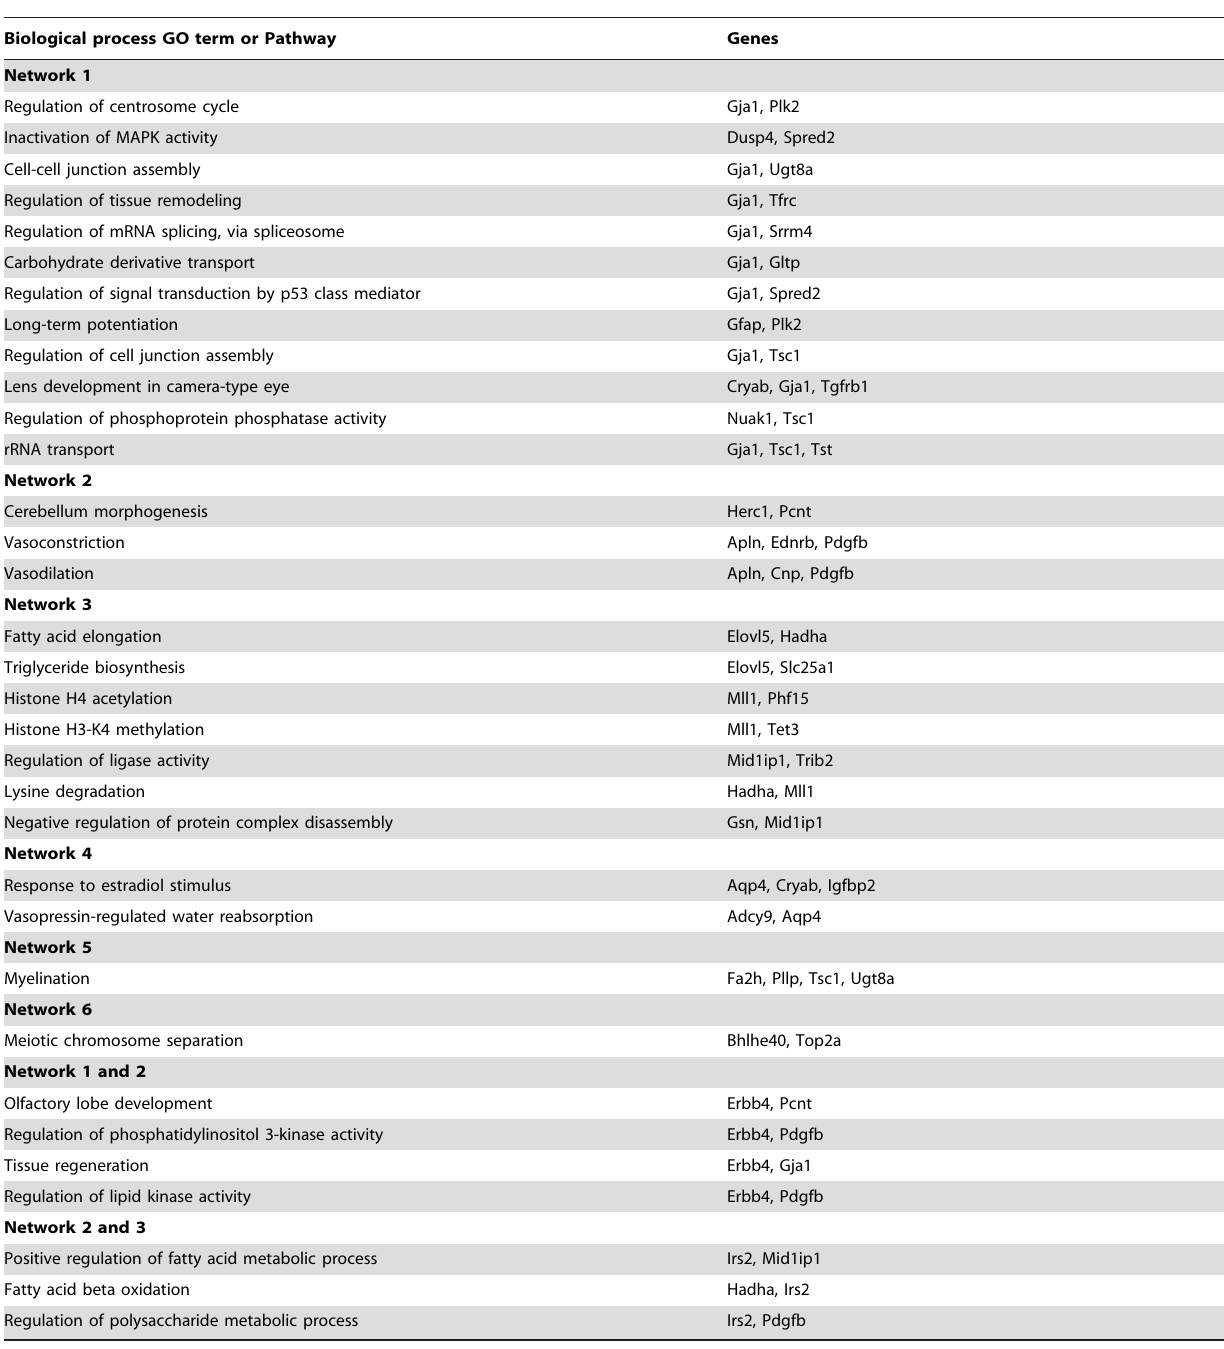
Table 4. E2-responsive networks and associated